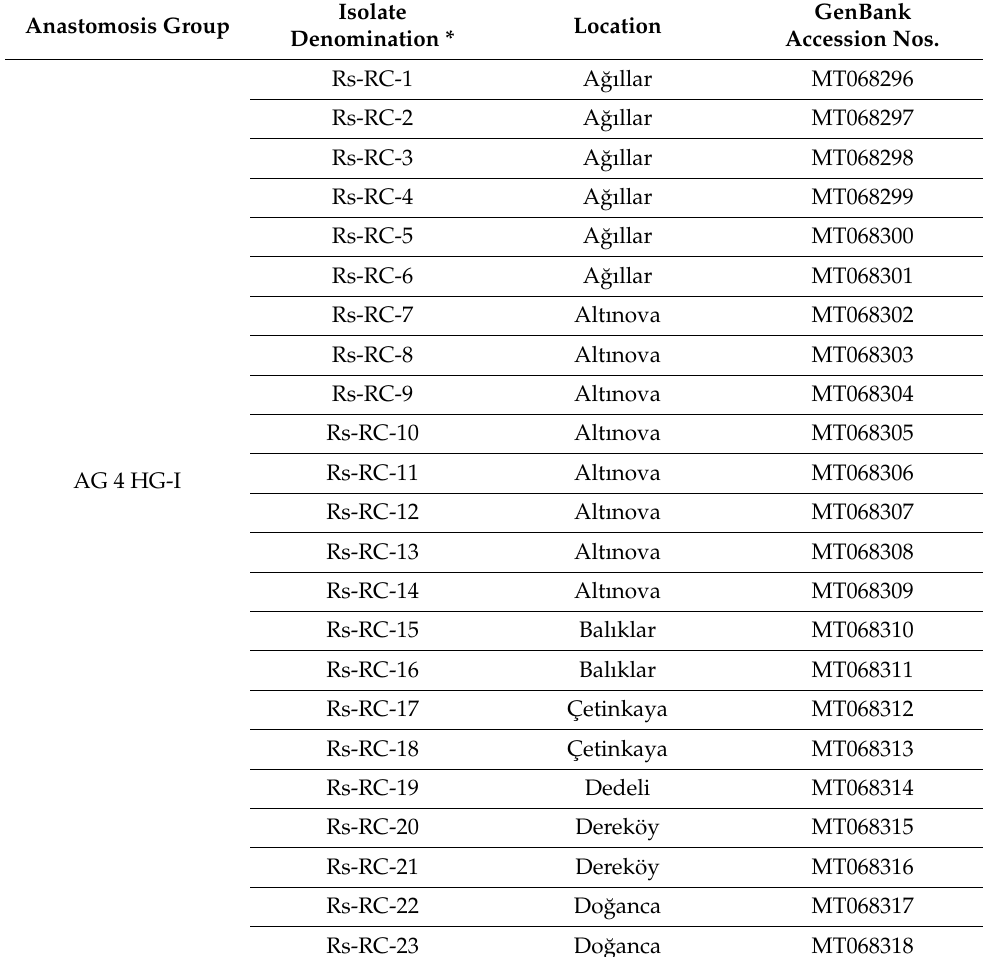
Table 2. Anastomosis groups, isolate numbers, and location of isolates of Rhizoctonia spp. including their accession numbers. Isolate Anastomosis Group